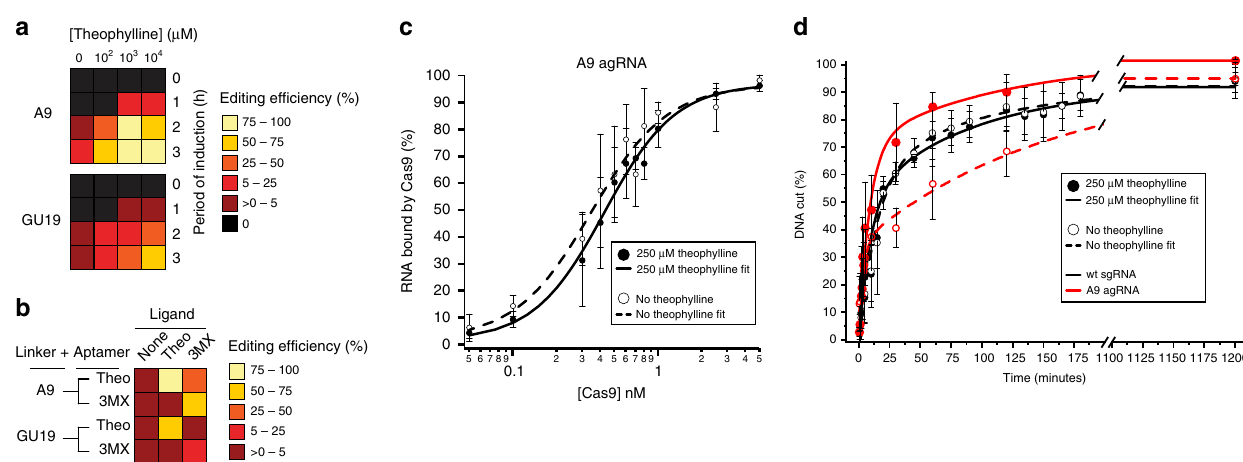
Fig. 2 Characterization of selected agRNAs. a Heat map of the editing ef fi ciency at the galK 1 site with the agRNAs A9 and GU19 as a function of the concentration of theophylline and the time of recovery with theophylline after transformation. In panels a and b, the color-coded values represent the average of three biological replicates. b Editing ef fi ciency at the galK 1 site was measured for agRNAs composed of the theophylline or 3MX- aptamer coupled via the linker A9 or GU19 in dependence of 1 mM theophylline (Theo) or 1 mM 3MX. Recovery time was 3 h. c Binding of Cas9 to sgRNA or agRNAs was observed and quanti fi ed via EMSA. Two representative binding curves for the A9 agRNA with and without 250 μ M theophylline are displayed. d Kinetics of in vitro endonuclease activity. Cas9 was incubated with different sgRNAs and a dsDNA target with or without theophylline. Error bars indicate standard deviation from the mean, each circle represents an average of three measurements. Source data are provided as a Source Data fi le.